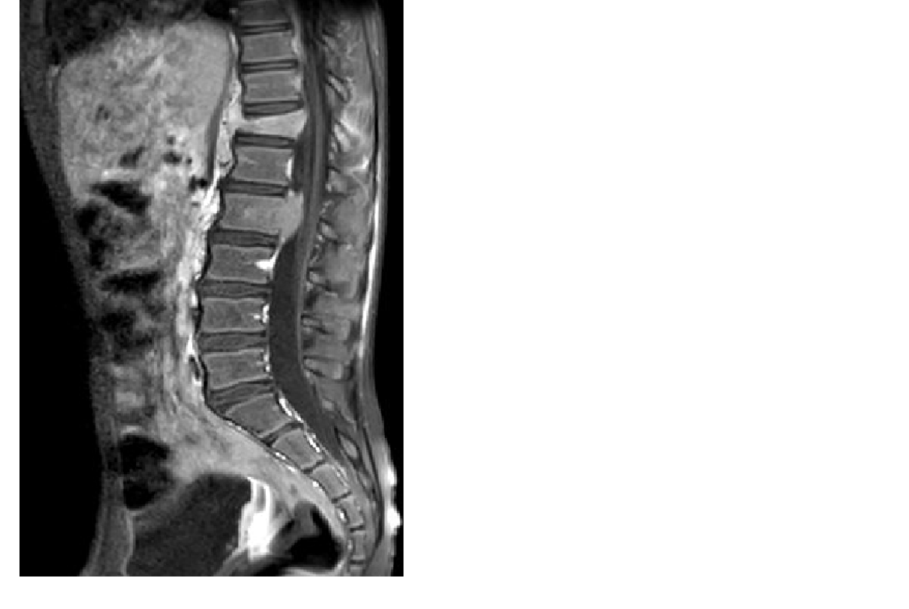
Figure 1. Spine MRI at onset: wedge-shaped D12 vertebral body and abnormal tissue proliferation with involvement of medullary canal at L1-L2 level.